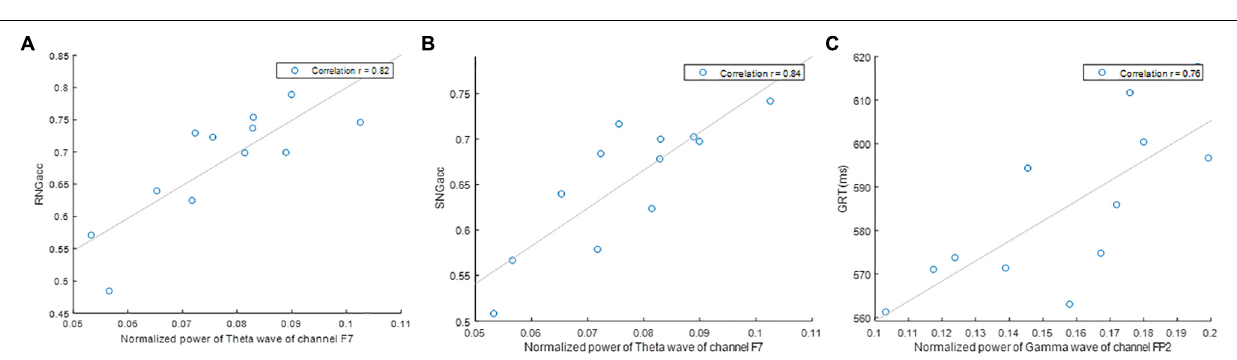
Frontiers in Neuroscience |